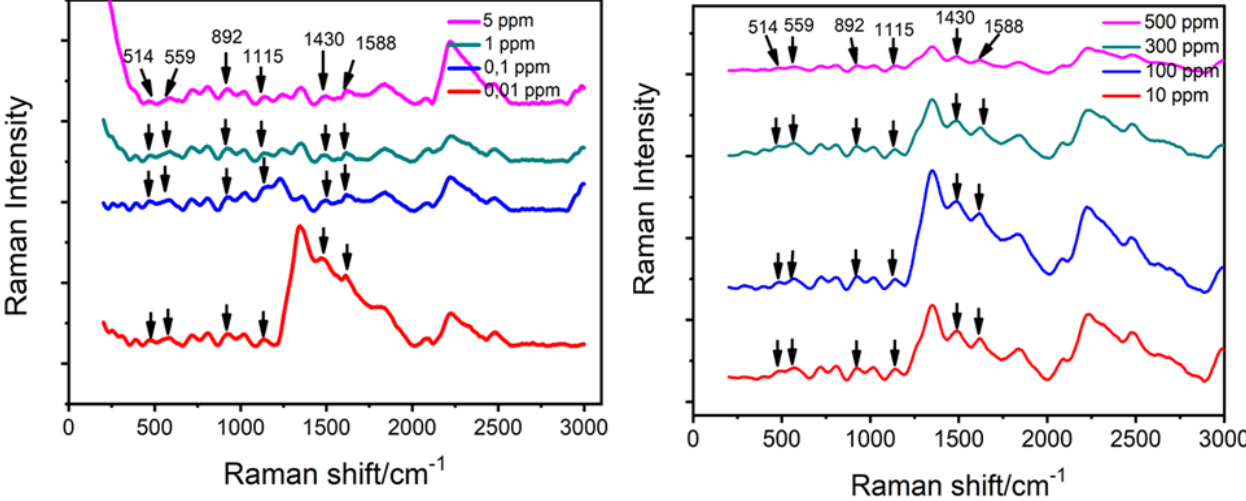
Figure 9. The SERS spectra of deltamethrin pesticide in a brewed tea using liquid SERS-based Au0Ag100 as a function of pesticide concentration ranging from 500 to 0.01 ppm.